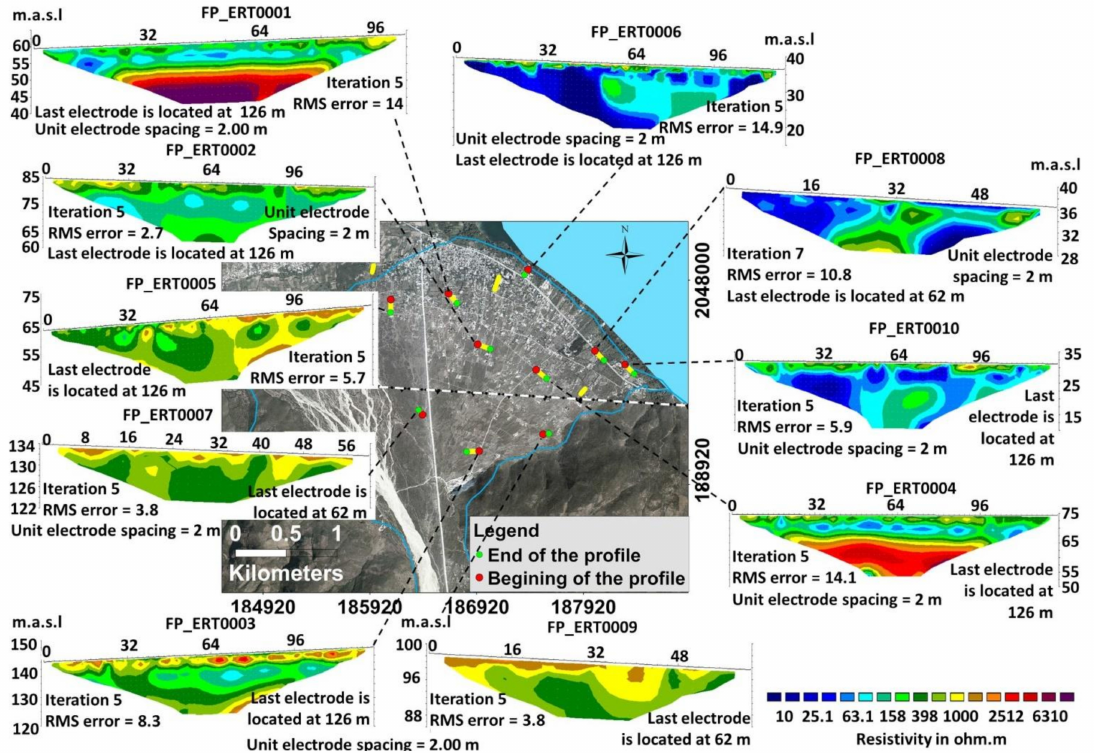
Figure 4. Examples of ERT profiles completed on the alluvial fan in the eastern part of Fond